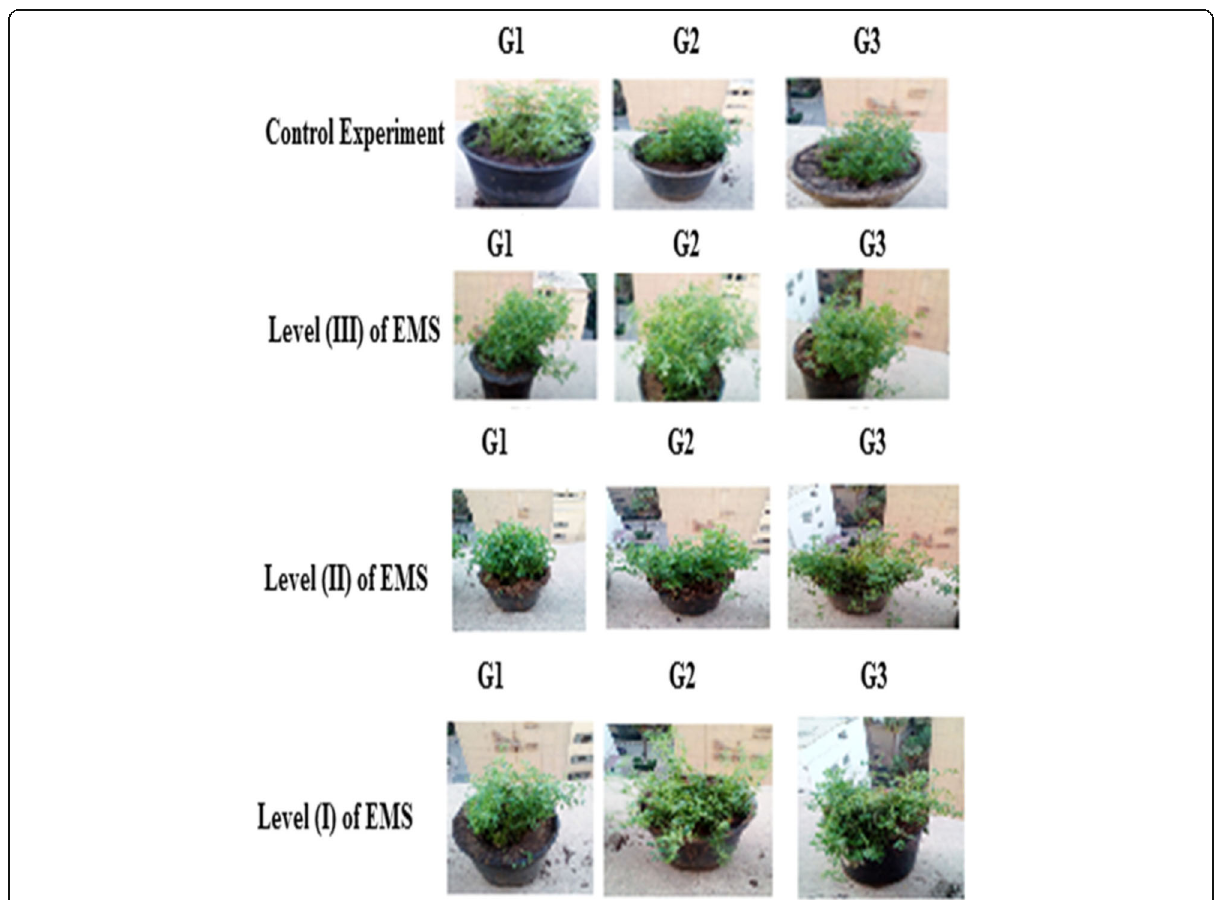
Fig. 1 Impact of the four ethyl methane sulfonate (EMS) (0, 0.1, 0.2, and 0.3) treatments for the three lentil cultivars G1 (Giza 9), G2 (Giza 29), and G3 (Giza 51),